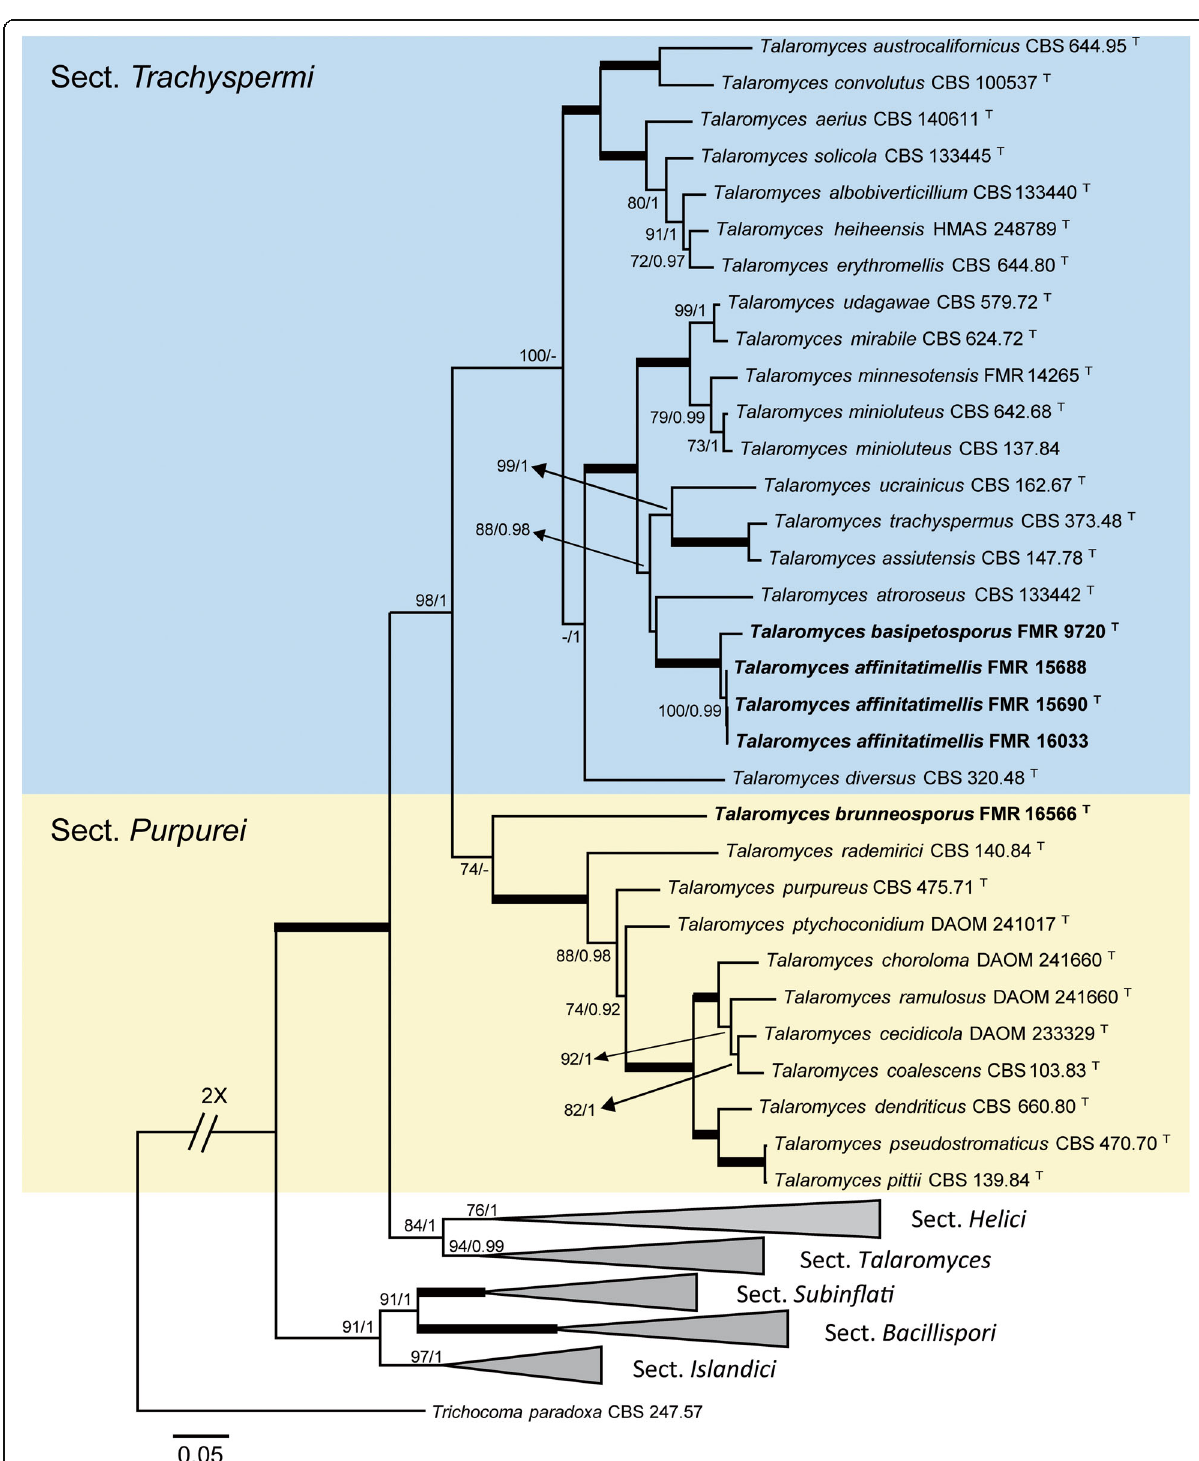
Fig. 4 ML phylogenetic tree built using the ITS, BenA , CaM and rpb 2 concatenated dataset for species of the genus Talaromyces . Species of the section Trachyspermi are indicated in a blue background and those of the section Purpurei in yellow. Trichocoma paradoxa CBS 247.57 was chosen as out-group. Support in nodes is indicated above thick branches and is represented by posterior probabilities (BI analysis) of 0.95 and higher and/or bootstrap values (ML analysis) of 70% and higher. Fully supported branched (100% BS /1 PP) are indicated in bold. T = ex-type strain. Alignment length 2265